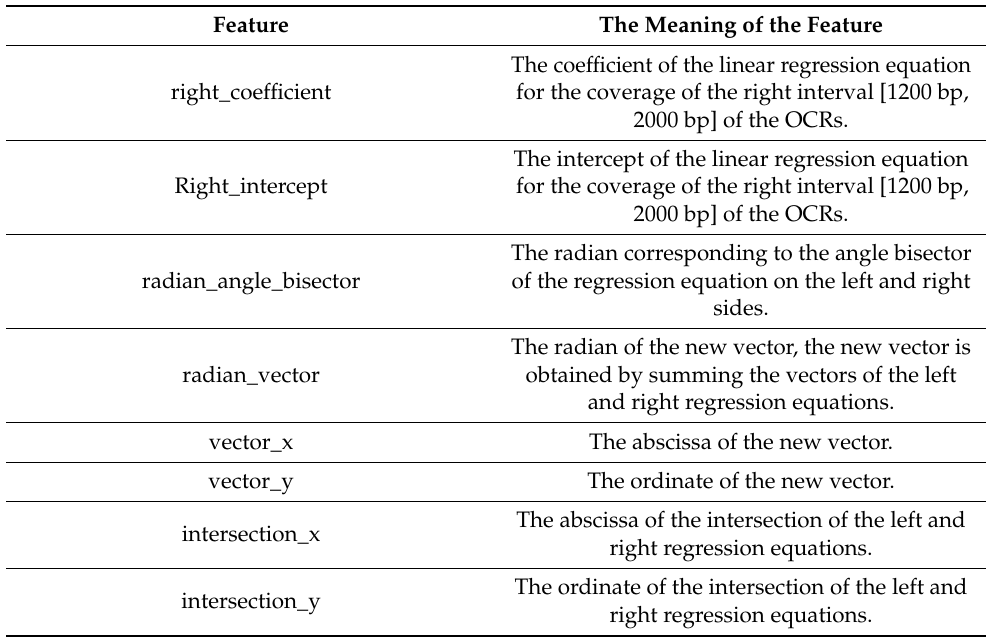
Table A2. Cont. Feature The Meaning of the Feature The coefficient of the linear regression right_coefficient